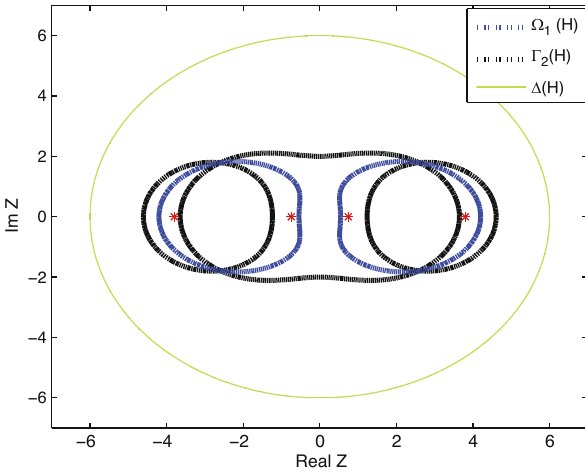
Figure 1: Comparisons of eigenvalue inclusion